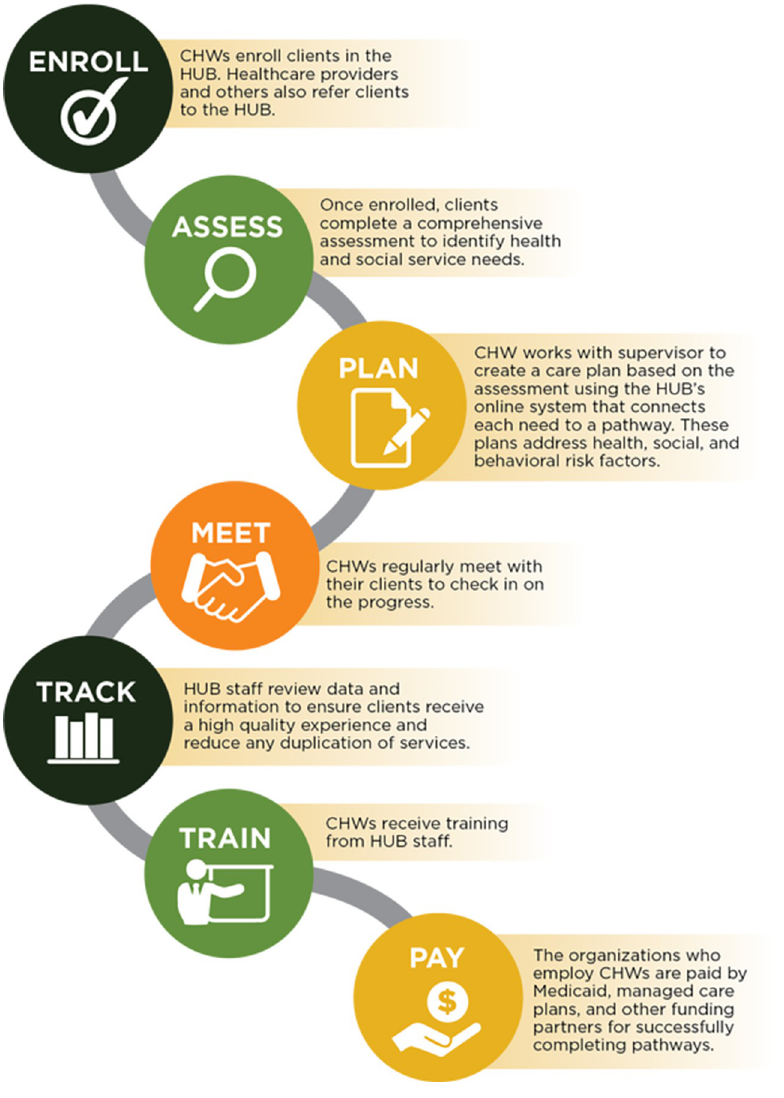
Fig 1. Consort 2010 flow